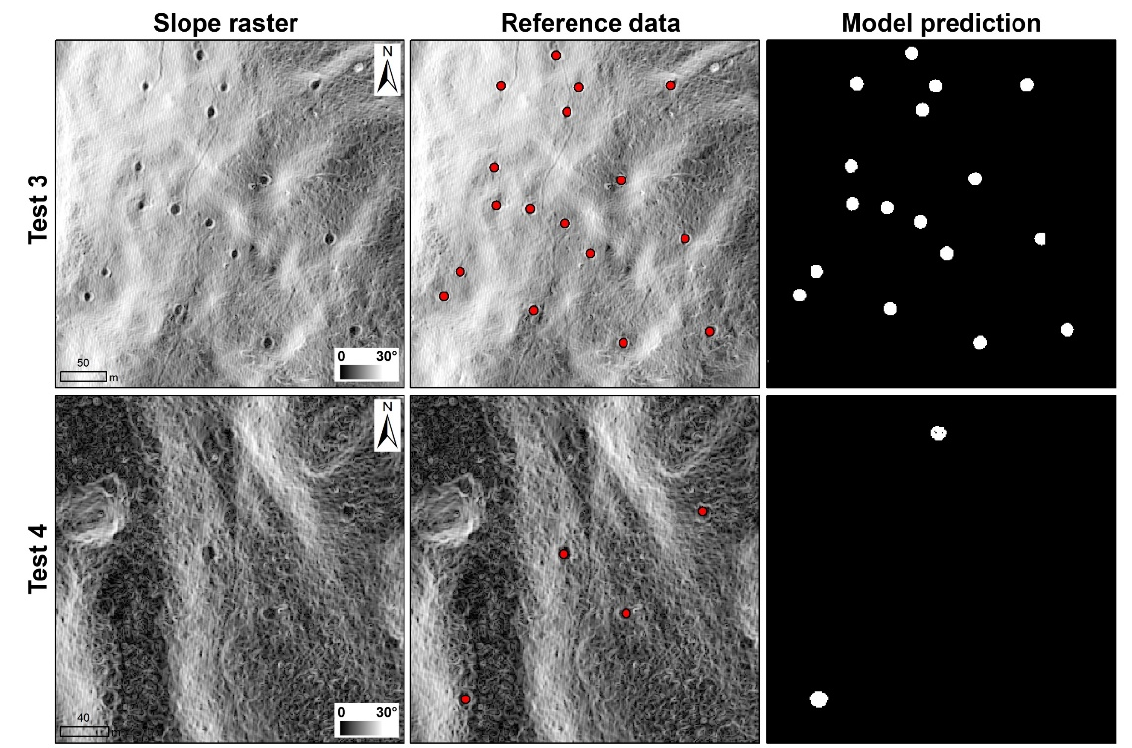
Figure 7. The comparison of model prediction results between a subset of test region 3 (RCHs on high slopes in deciduous forest) and 4 (RCHs on low slopes in coniferous forest). Model prediction results are from input scenario 1 (single slope raster). Table 5. The results for the entire test region after post-processing. For Cornwall Town, accuracy was calculated without including train region. Bold text represents the highest F1 score in each